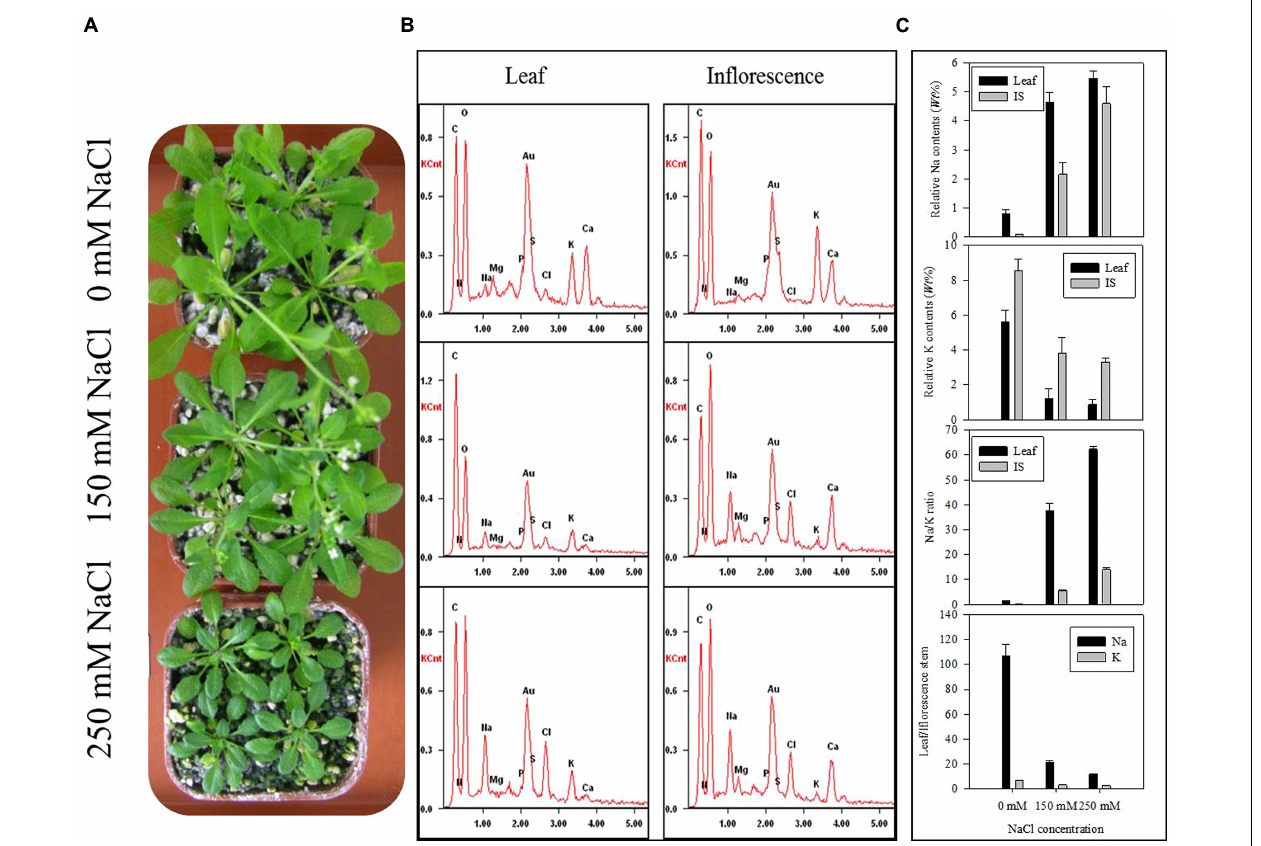
FIGURE 2 |The ionic accumulations in leaf and IS of seedlings exposed to nutrient solution containing 0, 150, or 250 mM NaCl detected by energy dispersive X-ray spectrometry. (A) The photographs of control and salt-stressed plants; (B) Energy dispersive